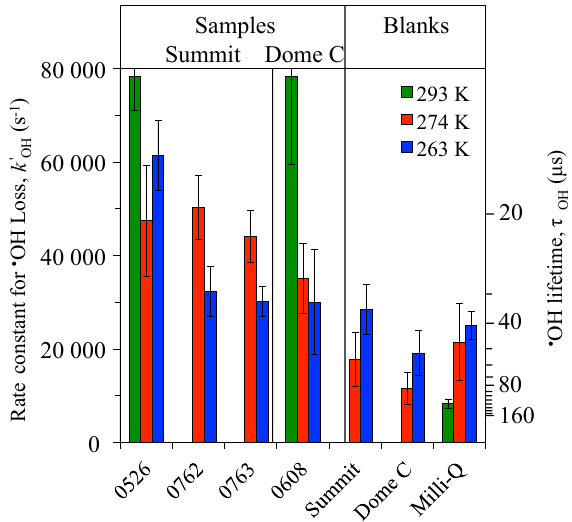
Figure 4. Laboratory-determined apparent rate constant for • OH destruction (left axis) and the corresponding • OH lifetime (right axis) in Summit and Dome C snow samples and Milli-Q field and lab blanks (with 100µM added HOOH) at 293K (green), 274K (red), and 263K (blue). Error bars represent ± 1 standard error, based on propagated standard errors (see text for